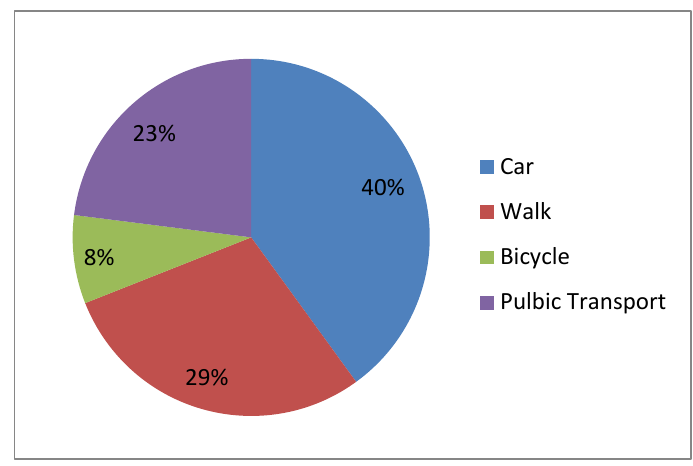
Figure 1. Modal split in the City of Stuttgart in 2017 (data taken from [39]).